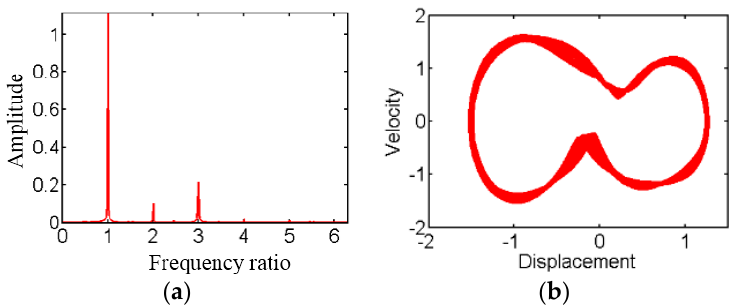
Figure 14. Dynamic behavior of system with the misalignment-rubbing coupling fault. (a) Spectrum diagram; (b) Phase diagram.